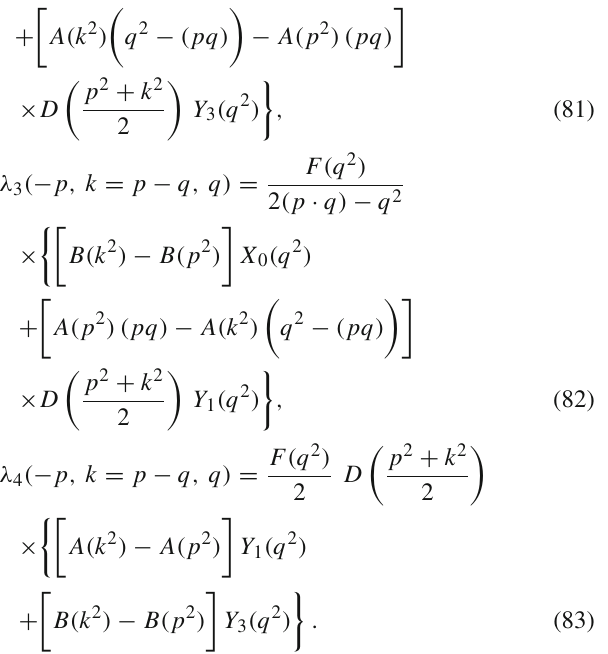
Our result differs significantly from the perturbative esti- mation of the form factors [5], where all the strength appears associated to λ 1 . For example, for the kinematical